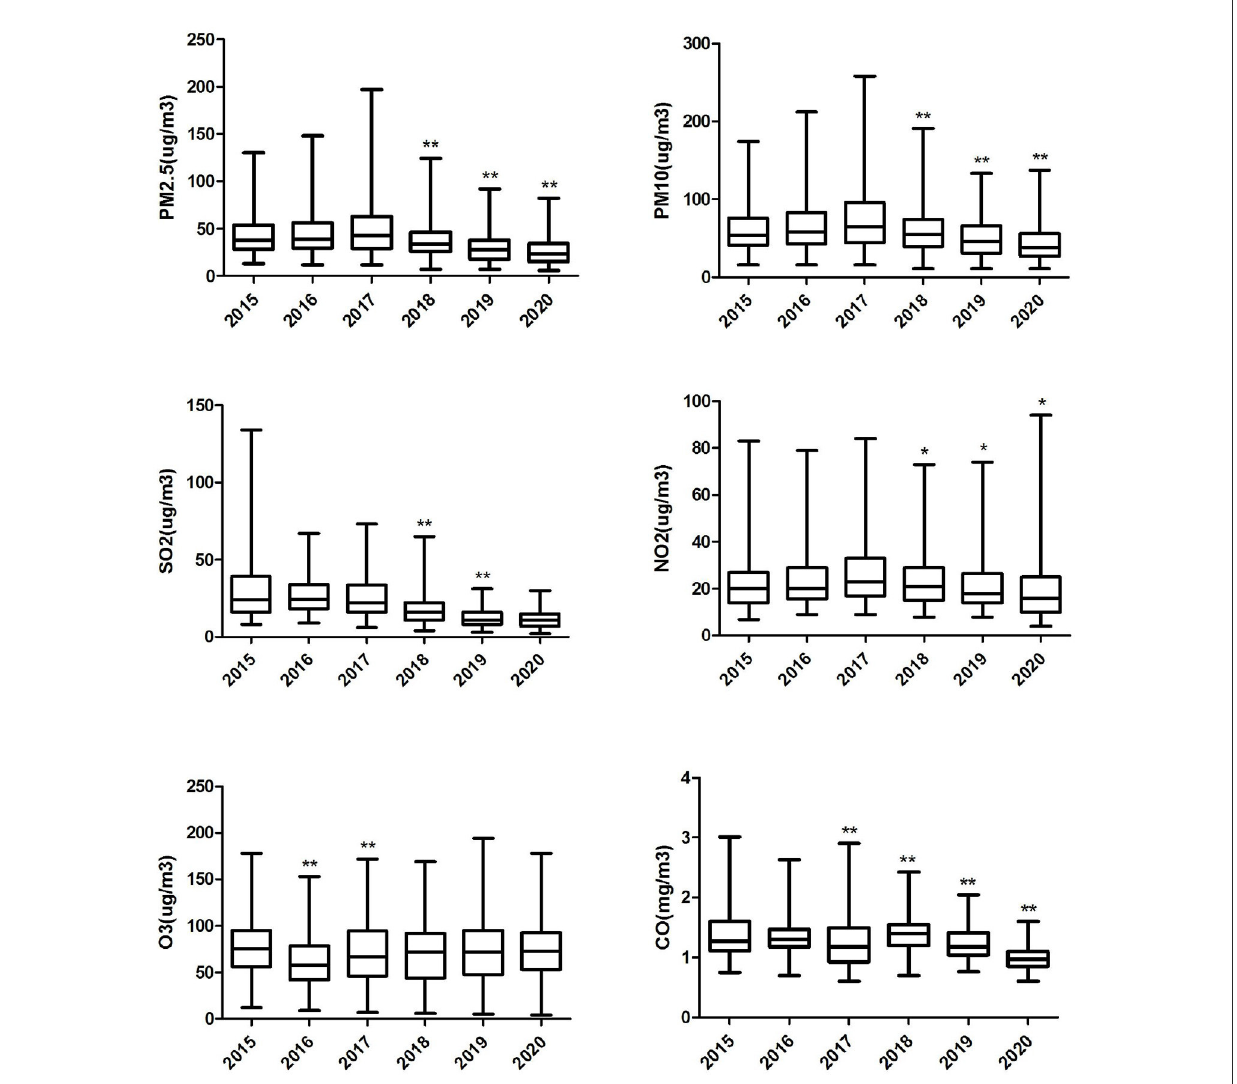
FIGURE2 Box plot of annual air pollution concentration in Ganzhou City, 2015–2020. “*” Differences between pollutant concentrations in the marker year and the previous year 0.001 ≤ P < 0.05. “**” Differences between pollutant concentrations in the marker year and the previous year P <